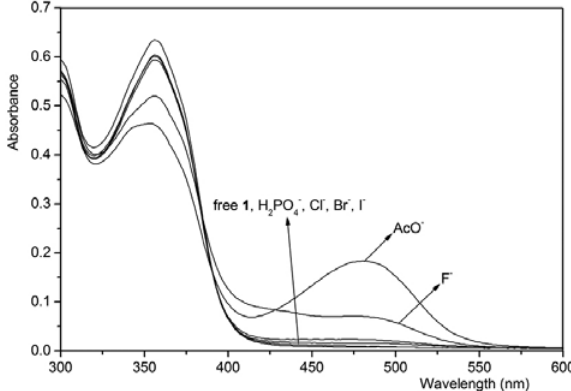
Fig. 4. Changes in absorption spectra of compound 1 (4.0 × 10 –5 mol·L –1 ) in presence of anions (8.0 × 10 –4 mol·L –1 )